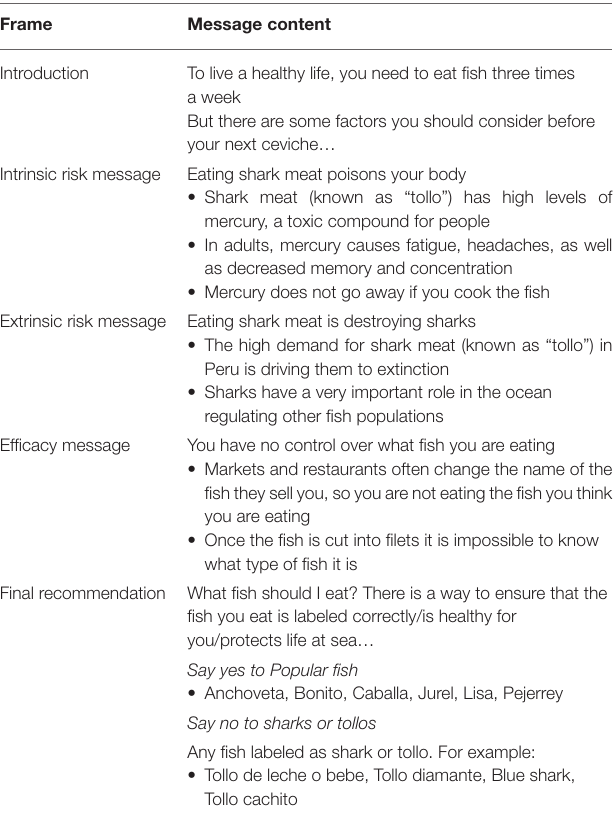
TABLE 1 | Experimental messages presented to